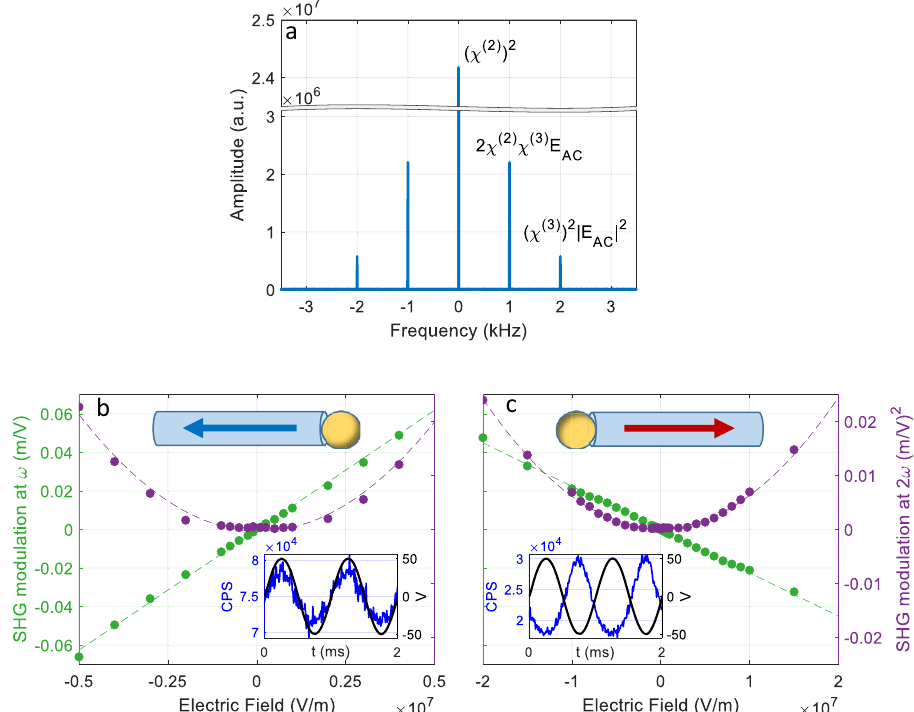
Fig. 3 Voltage-dependent EFM-SHG measurements. a FFT spectrum of an EFM-SHG measurement. The three frequency components are labelled according to Eq. (4). b The amplitudes at 1 kHz (green) and 2 kHz (purple) as a function of external applied fi led strength measured from a right-growing nanowire. The solid lines are linear and quadratic trend lines. c The same as in ( b ) but for a left-growing nanowire. The insets in ( b ) and ( c ) show the time- averaged SHG signal (blue) in counts per second (CPS) with respect to the applied AC voltage (black), as in Fig. 2e, d,